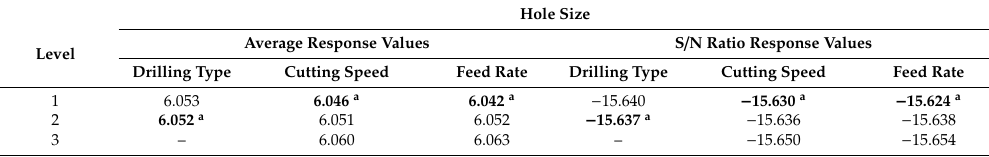
Table 6. Average response values and S / N ratios for hole